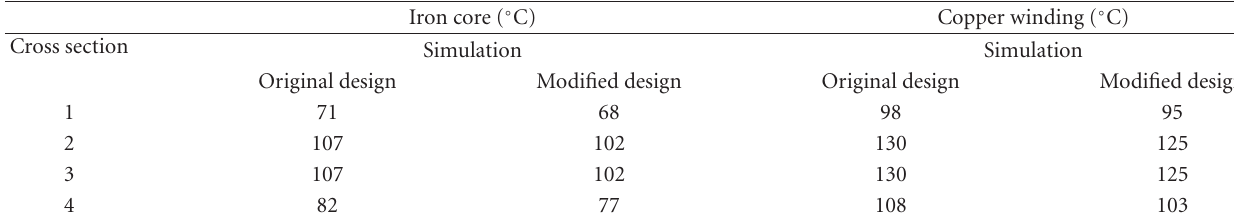
Table 5: Numerical results of average temperatures for the